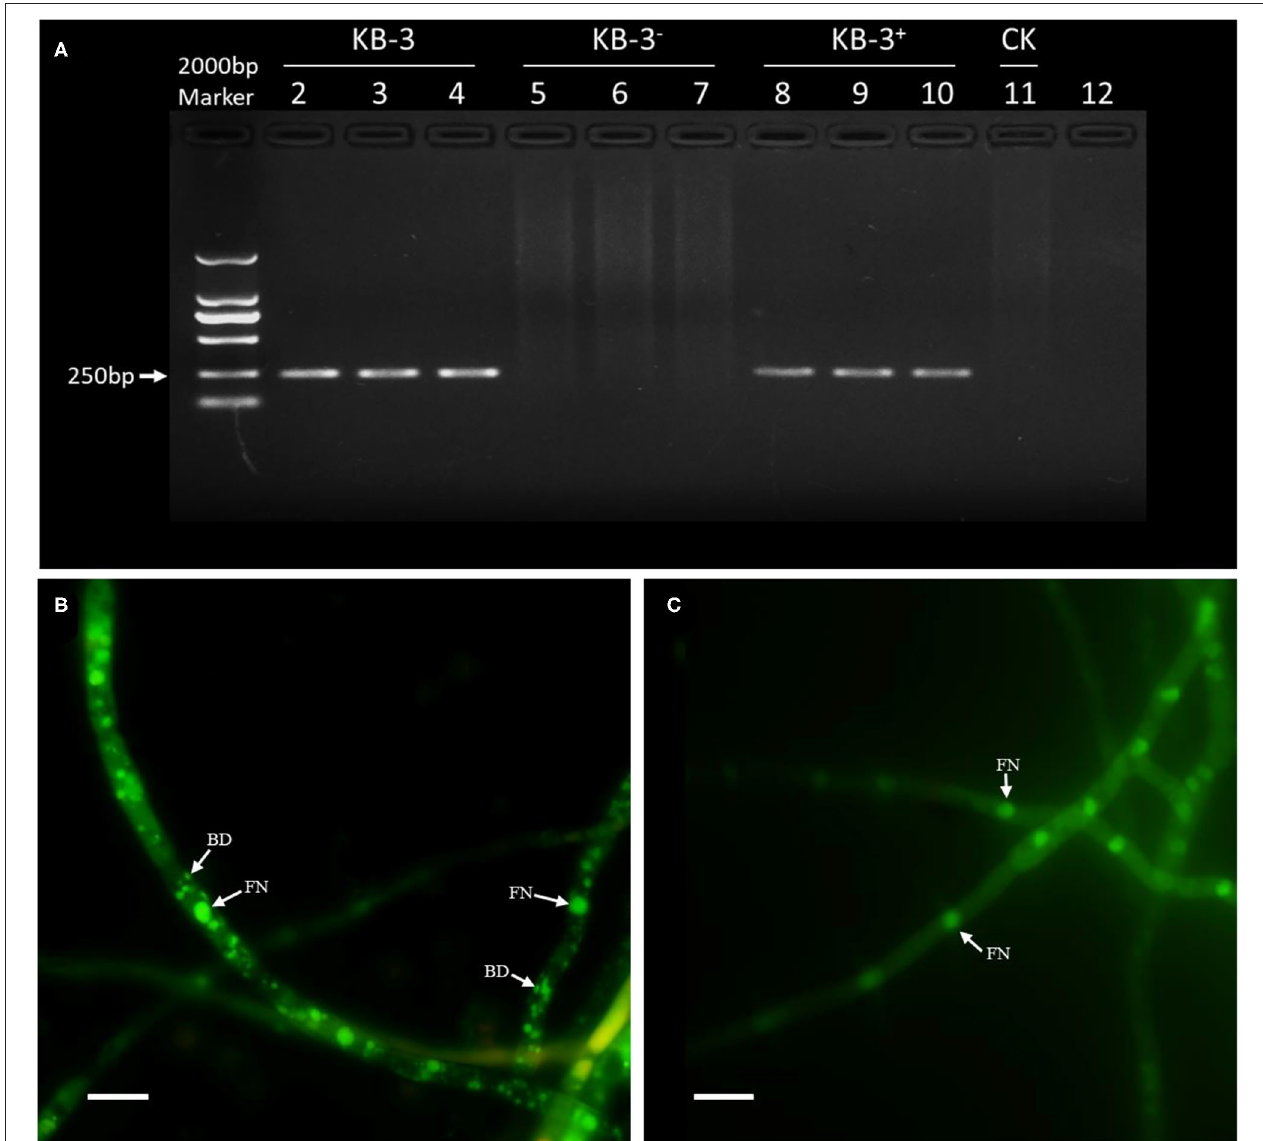
FIGURE 1 | The presence of endohyphal bacteria of Fusarium oxysporum KB-3. (A) PCR amplification of 16S rDNA for wild strain KB-3 (KB-3, lanes 2–4), cured strain KB-3 (KB-3 − , lanes 5–7), restored strain KB-3 (KB-3 + , lanes 8–10), and the final rinse solution of wild strain for endohyphal bacterial isolation (lane 11). (B) SYTO-9 fluorescent nucleic acid stained the wild strain KB-3 hyphae. (C) SYTO-9 fluorescent nucleic acid stained the cured strain KB-3 − hyphae. FN, fungal nucleus; BD, bacterial DNA. Bars = 10 µ m.